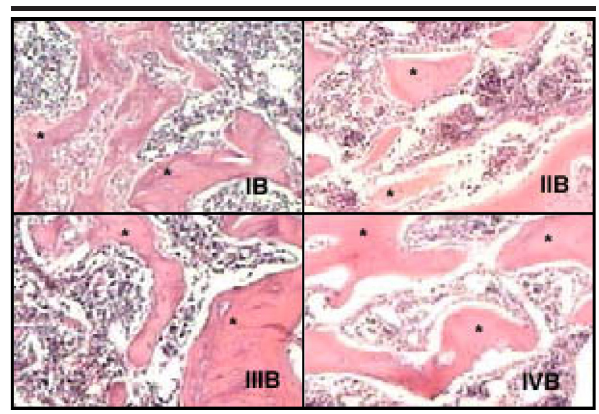
FIGURE 2 - Photomicrographies showing the trabecular formation (*) in the defect areas under light microscopy. Follow-up 14 days.HE-100X